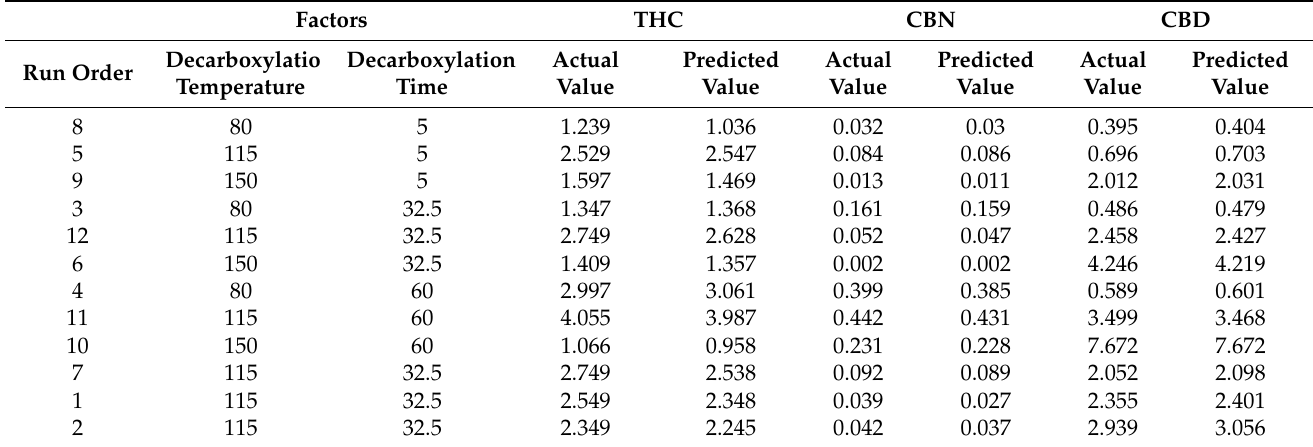
Table 1. Design of experiment by response surface methodology.